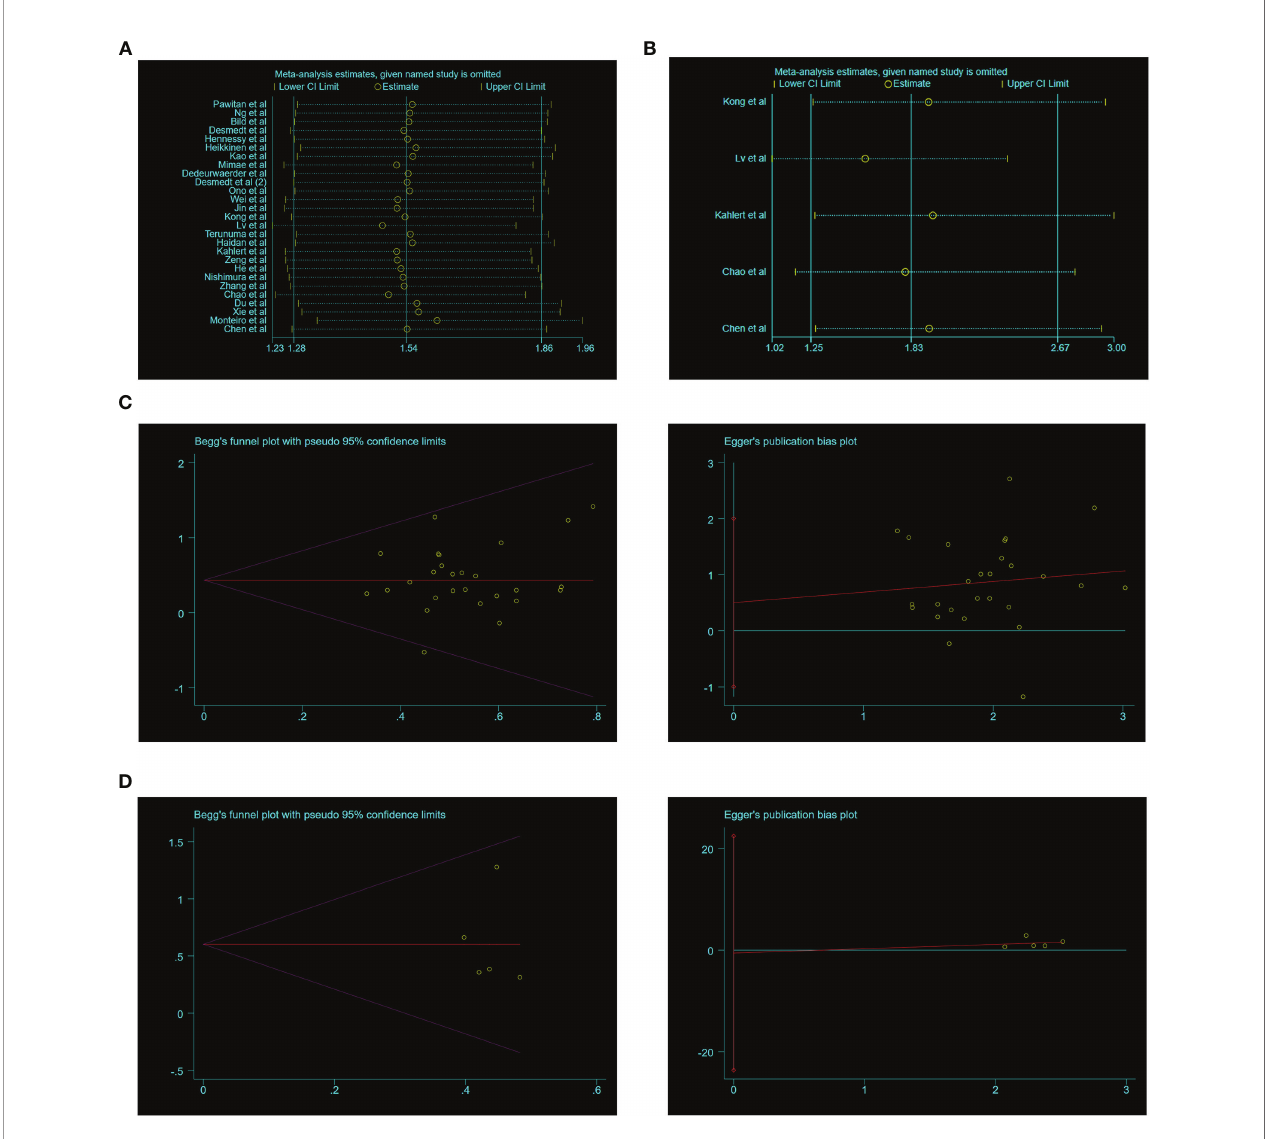
FIGURE 4 | Sensitivity analysis and publication bias of the meta-analysis. (A) . OS of SIX1 expression levels; (B) . DFS of SIX1 expression levels; (C) . OS of Begg ’ s funnel plots(left) and Egger ’ s plots (right); (D) . DFS of Begg ’ s funnel plots(left) and egger ’ s plots